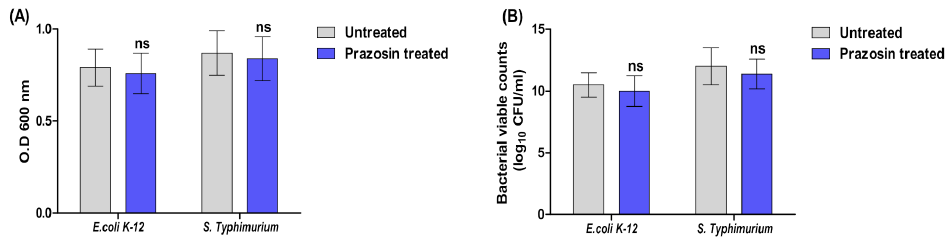
Figure 2. Prazosin at sub − MIC has no effect on bacterial growth. The bacterial cultures were grown in the presence or absence of prazosin. ( A ) The optical densities, ( B ) Bacterial counts were determined, and there were no significant differences between the growth in the presence or absence of